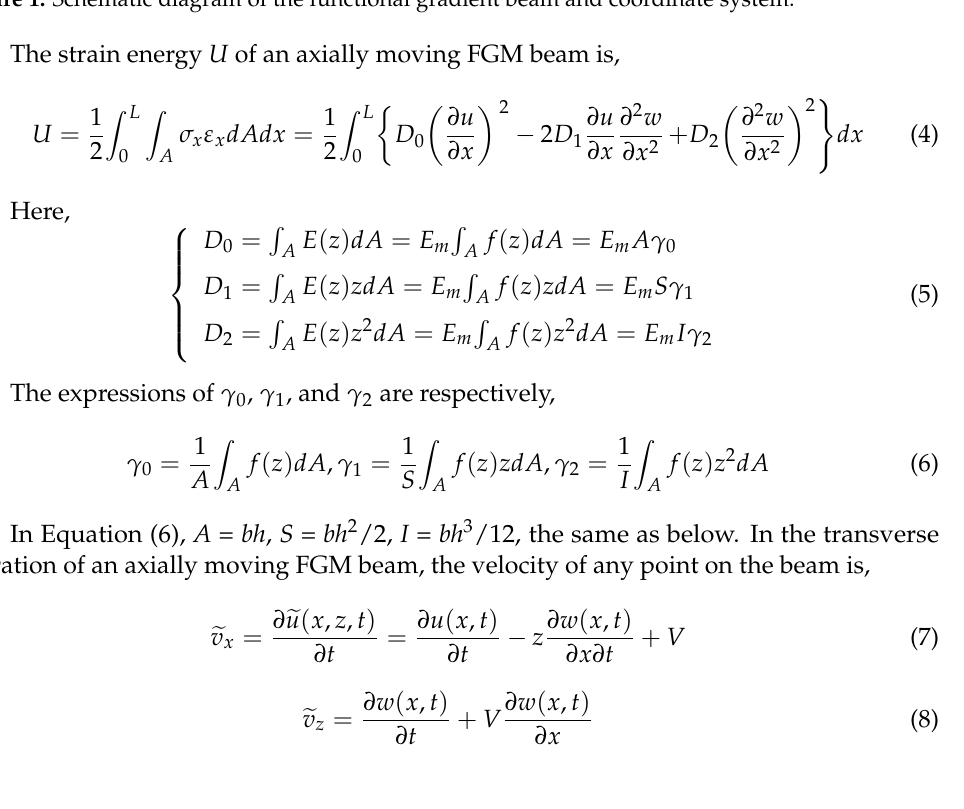
Figure 1. Schematic diagram of the functional gradient beam and coordinate system.